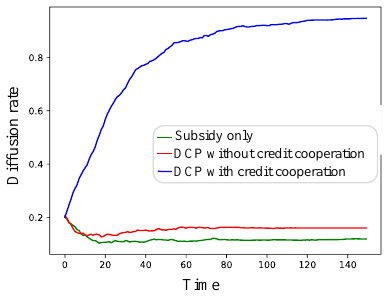
Figure 8. Results in scale free network.